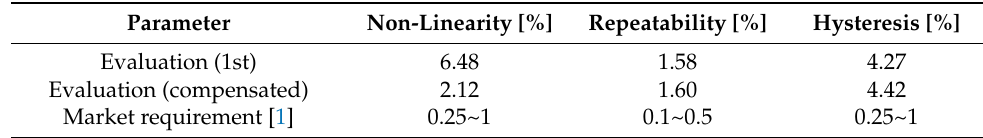
Table 2. PLC Table 2. PLC performance.